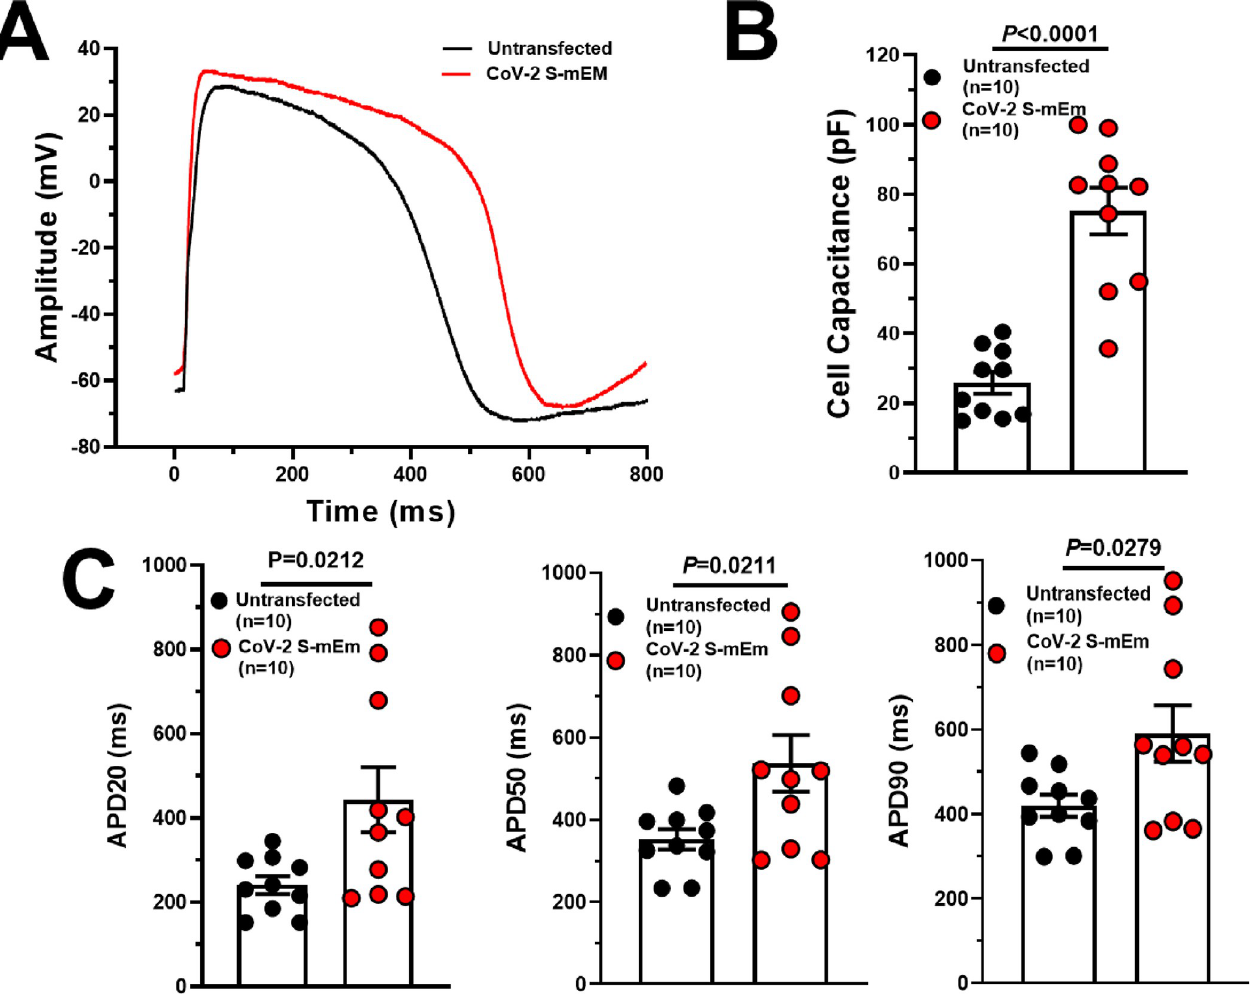
Fig 2. SARS-CoV-2 spike protein-induced hiPSC-CM syncytia exhibit reduced repolarization reserve with marked prolongation in action potential duration (APD). ( A ) Representative action potential traces derived from untransfected and CoV-2 S-mEm-transfected hiPSC-CMs. ( B ) Cell capacitance in untransfected (n = 10) and CoV-2 S-mEm-transfected (n = 10) hiPSC-CMs. ( C ) Action potential duration at 20% (APD20; left), 50% (APD50; middle) and 90% (APD90; right) in untransfected hiPSC-CMs (n = 10) paced at 1 Hz and CoV-2 S-mEm-transfected hiPSC-CMs paced at 1 Hz (8 cells) and 0.67 Hz normalized to 1 Hz (2 cells). Graphs are presented as mean ± SEM. Unpaired two-tailed Student’s t-tests were conducted to determine significance.